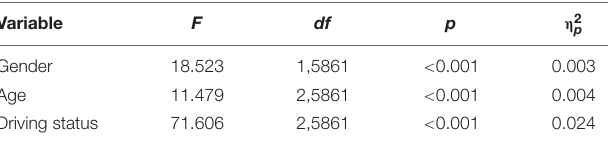
TABLE 5 | Main effect results for the three between groups variables on quality of life.